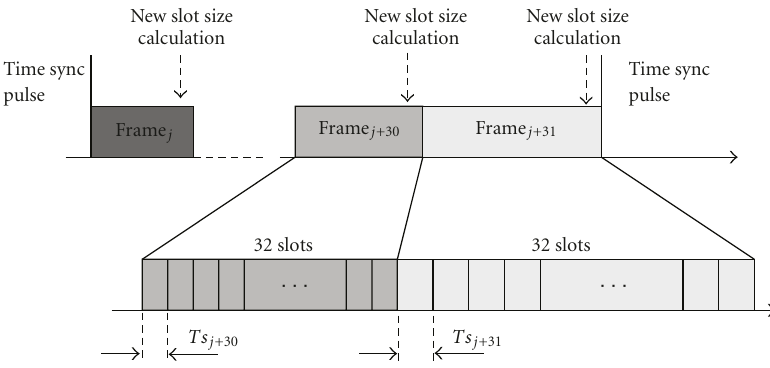
Figure 10: Slot size randomization on a frame-by-frame